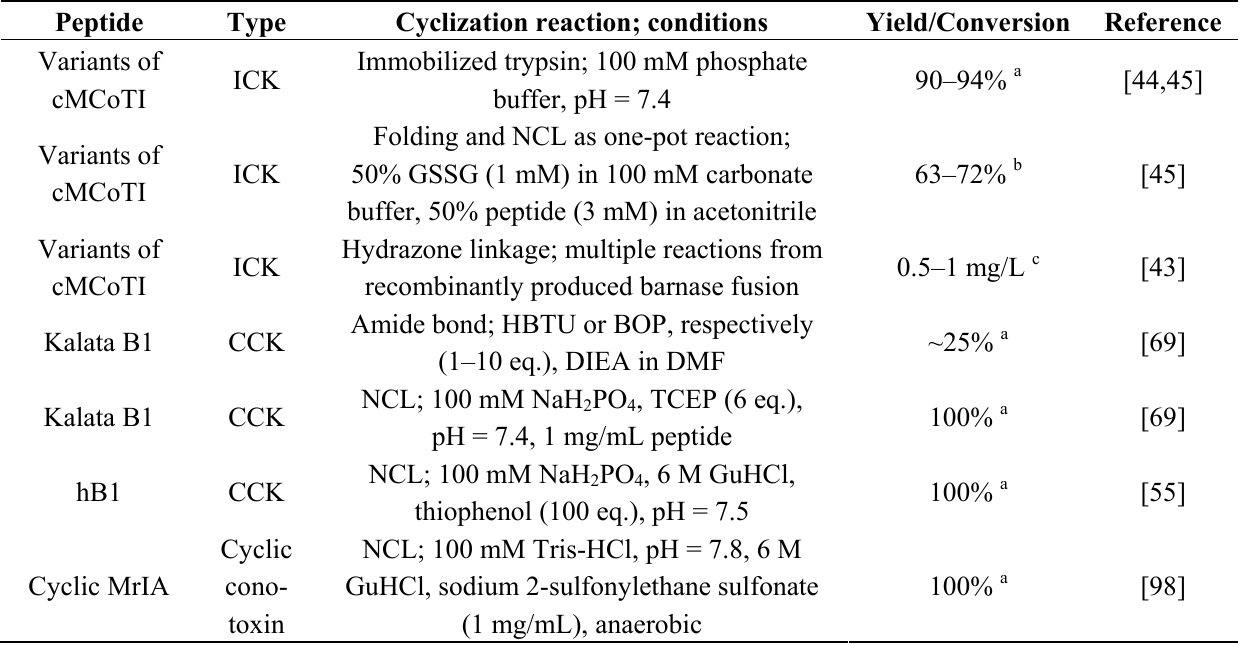
Table 2. Selected cyclization conditions for a number of cystine-knot peptides from various families.